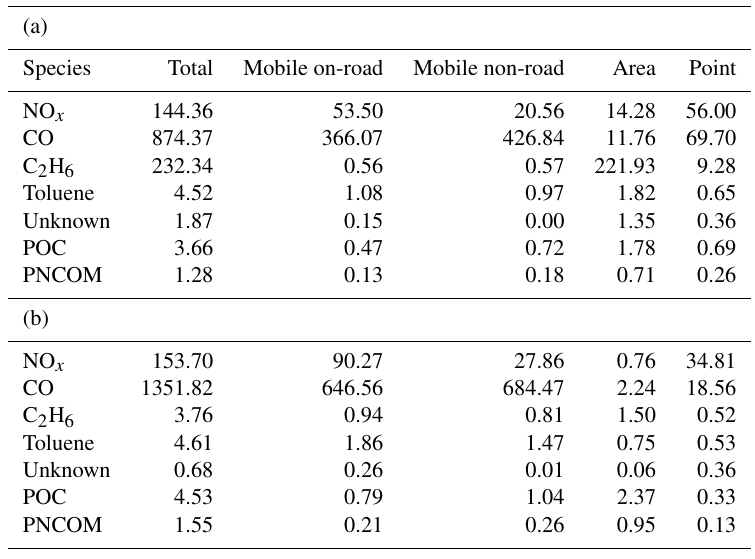
Table 3. NEI-2011 emissions (July, weekday) for the Denver–Julesburg basin box, 39.8–40.7 ◦ N, 104.25–105.4 ◦ W (9764km 2 ) . Top-down estimates for C 2 H 6 and toluene point and area sources are indicated. Units are kilo moleh − 1 for gas-phase species and short tonsday − 1 for POC (primary organic carbon) and PNCOM (primary non-carbon organic matter).